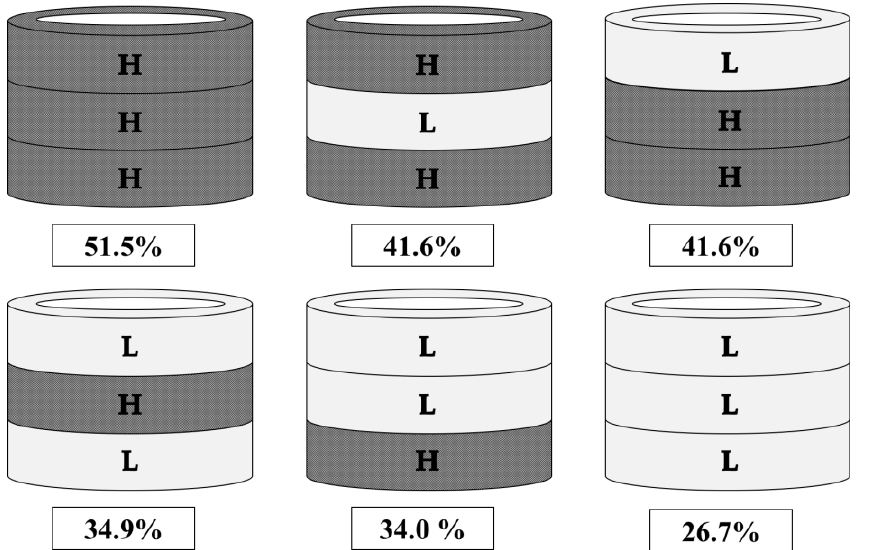
Figure 1. The six three-layered hollow cylinder samples and their total % sugar concentration ( w / w ) where H represents a high sugar layer (51.5%) and L a low sugar layer (26.7%). Chocolate samples are named by using upper case letters to represent layering order from bottom to top (HHH, HLH, HHL, LHL, HLL, LLL).